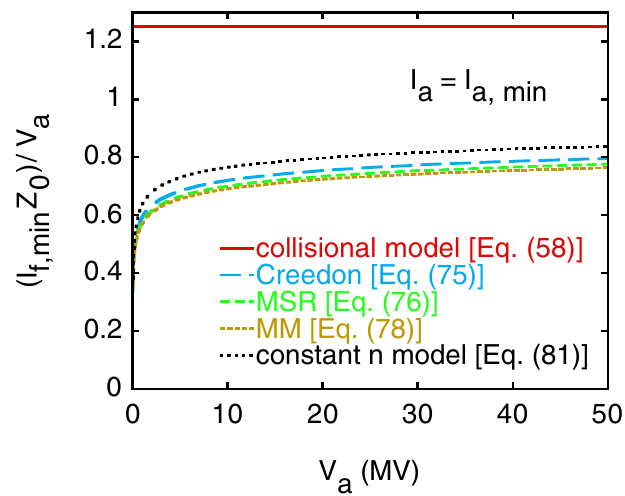
Z =V FIG. 3. (Color) The ratio I as a function of V for a f; min a a 0 (cid:14) 50 MV . The quan- 1D planar MITL, plotted for 50 kV (cid:14) V a (cid:1) I is the electron-flow current when I . The ratio tity I f; min a a; min is plotted for the collisional model [Eq. (58)] and four collision- less models [Eqs. (75), (76), (78), and (81)]. Equation (75) is obtained by Creedon [8,9], Eq. (76) by Mendel, Seidel, and Rosenthal [27], and Eq. (78) by Miller and Mendel [30]. * [Eq. (81) is obtained in the present article.] When V a are expected 1 MV , experimentally observed values of I f; min to fall between the collisional and collisionless limits.